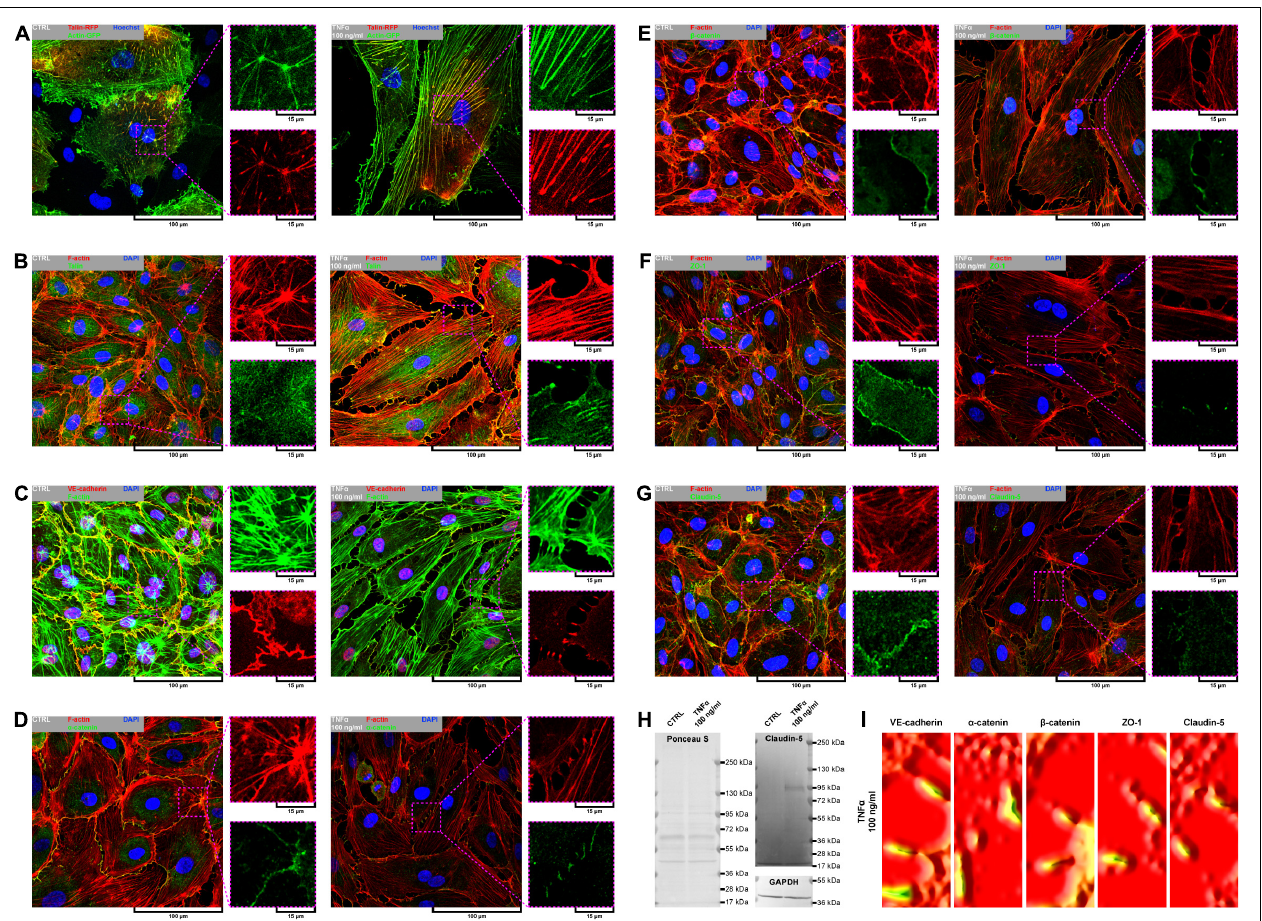
FIGURE 3 | Effect of TNF α on organizational pattern of F-actin, distribution of adhesion sites, and organization of cell–cell junctions in pHCAECs. (A) Representative confocal micrograph of intravital organization of F-actin and focal adhesion sites. Actin-GFP (red) and talin-RFP (green) were expressed using baculoviruses. Nuclei (blue) were stained with Hoechst 33342. CTRL refers to the control (left panel), TNF α 100 ng/ml to cells treated with rh TNF α (right panel). (B) Representative confocal micrograph of fluorescently stained F-actin and talin. Triple fluorescent staining for talin (green), F-actin (red), and DNA (blue) was performed after fixation. CTRL refers to the control (left panel), TNF α 100 ng/ml to cells treated with rh TNF α (right panel). (C) Representative confocal micrograph of fluorescently stained F-actin and VE-cadherin. Triple fluorescent staining for VE-cadherin (red), F-actin (green), and DNA (blue) was performed after fixation. CTRL refers to the control (left panel), TNF α 100 ng/ml to cells treated with rh TNF α (right panel). (D) Representative confocal micrograph of fluorescently stained F-actin and α -catenin. Triple fluorescent staining for α -catenin (green), F-actin (red), and DNA (blue) was performed after fixation. CTRL refers to the control (left panel), TNF α 100 ng/ml to cells treated with rh TNF α (right panel). (E) Representative confocal micrograph of fluorescently stained F-actin and β -catenin. Triple fluorescent staining for β -catenin (green), F-actin (red), and DNA (blue) was performed after fixation. CTRL refers to the control (left panel), TNF α 100 ng/ml to cells treated with rh TNF α (right panel). (F) Representative confocal micrograph of fluorescently stained F-actin and ZO-1. Triple fluorescent staining for ZO-1 (green), F-actin (red), and DNA (blue) was performed after fixation. CTRL refers to the control (left panel), TNF α 100 ng/ml to cells treated with rh TNF α (right panel), ZO-1 to zonula occludens-1. (G) Representative confocal micrograph of fluorescently stained F-actin and claudin-5. Triple fluorescent staining for claudin-5 (green), F-actin (red), and DNA (blue) was performed after fixation. CTRL refers to the control (left panel), TNF α 100 ng/ml to cells treated with rh TNF α (right panel). (H) Representative western blots for claudin-5 (upper right panel) and GAPDH (lower right panel) in lysates form pHCAECs. Protein transfer efficiency was assessed by Ponceau S staining (left panel). CTRL refers to the control (left lines), TNF α 100 ng/ml to cells treated with rh TNF α (right lines). (I) Representative surface plots of fluorescence intensity of VE-cadherin, α -catenin, β -catenin, ZO-1, and claudin-5 from regions of cell–cell interactions between rh TNF α pHCAECs. TNF α 100 ng/ml refers to cells treated with rh TNF α , ZO-1 to zonula